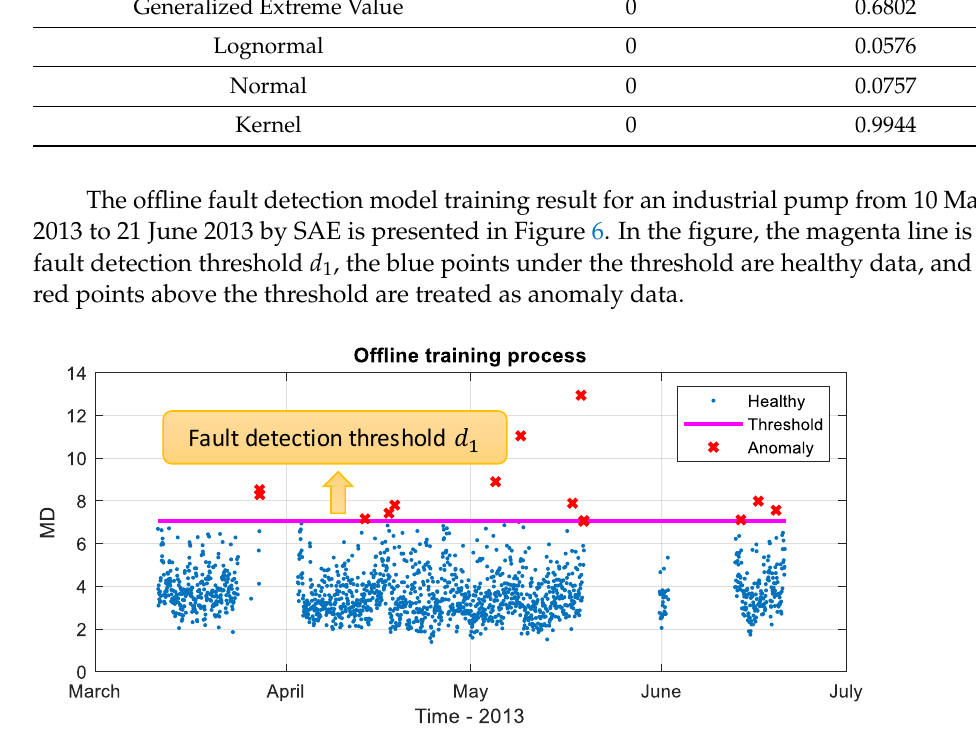
Figure 6. Offline fault detection model training for an industrial pump from 10 March 2013 to 21 June 2013 by the sparse autoencoder (SAE; blue points: healthy data; red points: anomalies; magenta line: reference MD thresholds).